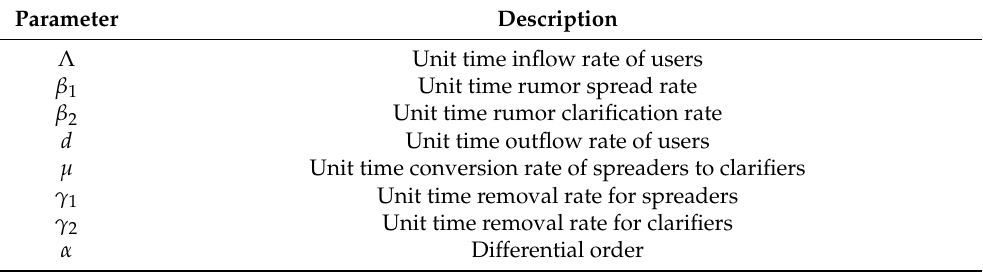
Table 1. Description of the parameters used in numerical siumlations.